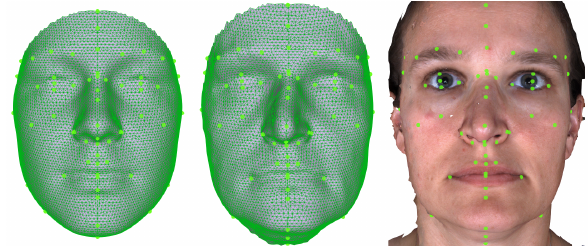
Figure 1. Non-rigid transformation of the AM with template landmarks (left) to a target face showing the resulting deformation (centre), followed by landmark transfer to the target face using barycentric coordinates (right).